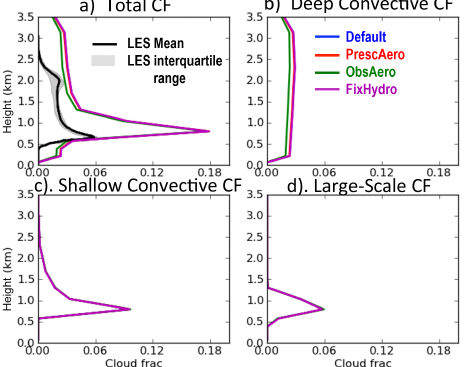
Figure 8. Time-averaged profiles cloud fraction (CF) quantities from RICO simulations. Default, PrescAero, and ObsAero all lie on top of one another. LES data are from VZ11.